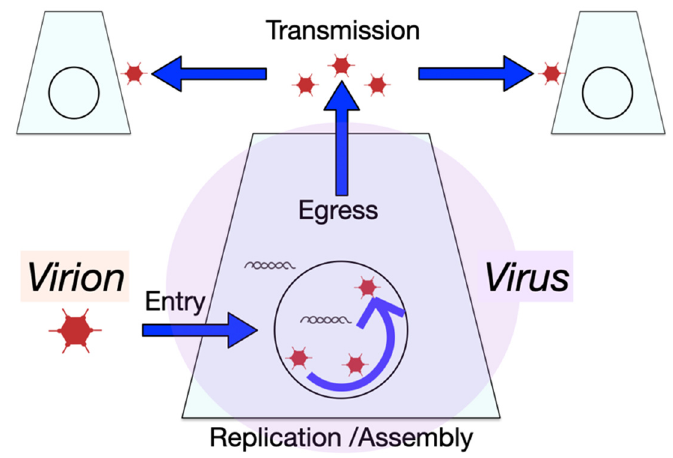
Figure 1. Schematic depiction of a virus-centric view into single-cell infection and dissemination of progeny to uninfected cells.